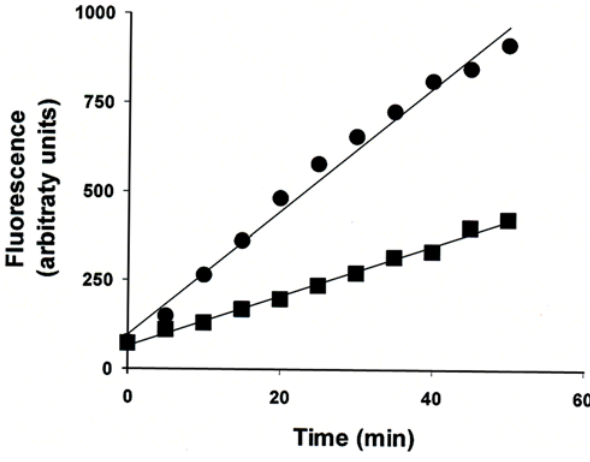
N Figure 7. The activity is secreted and intracellular ADAMTS13. ) and intracellular ADAMTS13 ( & ). Activity of Activity of secreted ( intracellular ADAMTS13 was measured using the FRETS-VWF73 assay described in Fig. 4. The secreted ADAMTS13 was collected from the media which was concentrated using a Centriprep 30 centrifrugal filter device. The data were corrected for amount of ADAMTS13 in each sample as described in Fig. 4. The activities for the secreted and intracellular ADAMTS13 were 17.3 arbitrary units/min/unit protein and 8.8 arbitrary units/min/unit protein respectively. Typical traces from three independent experiments are depicted.